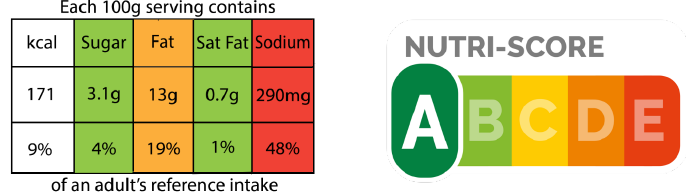
Figure 1. Front-of-pack labels under consideration in Singapore.